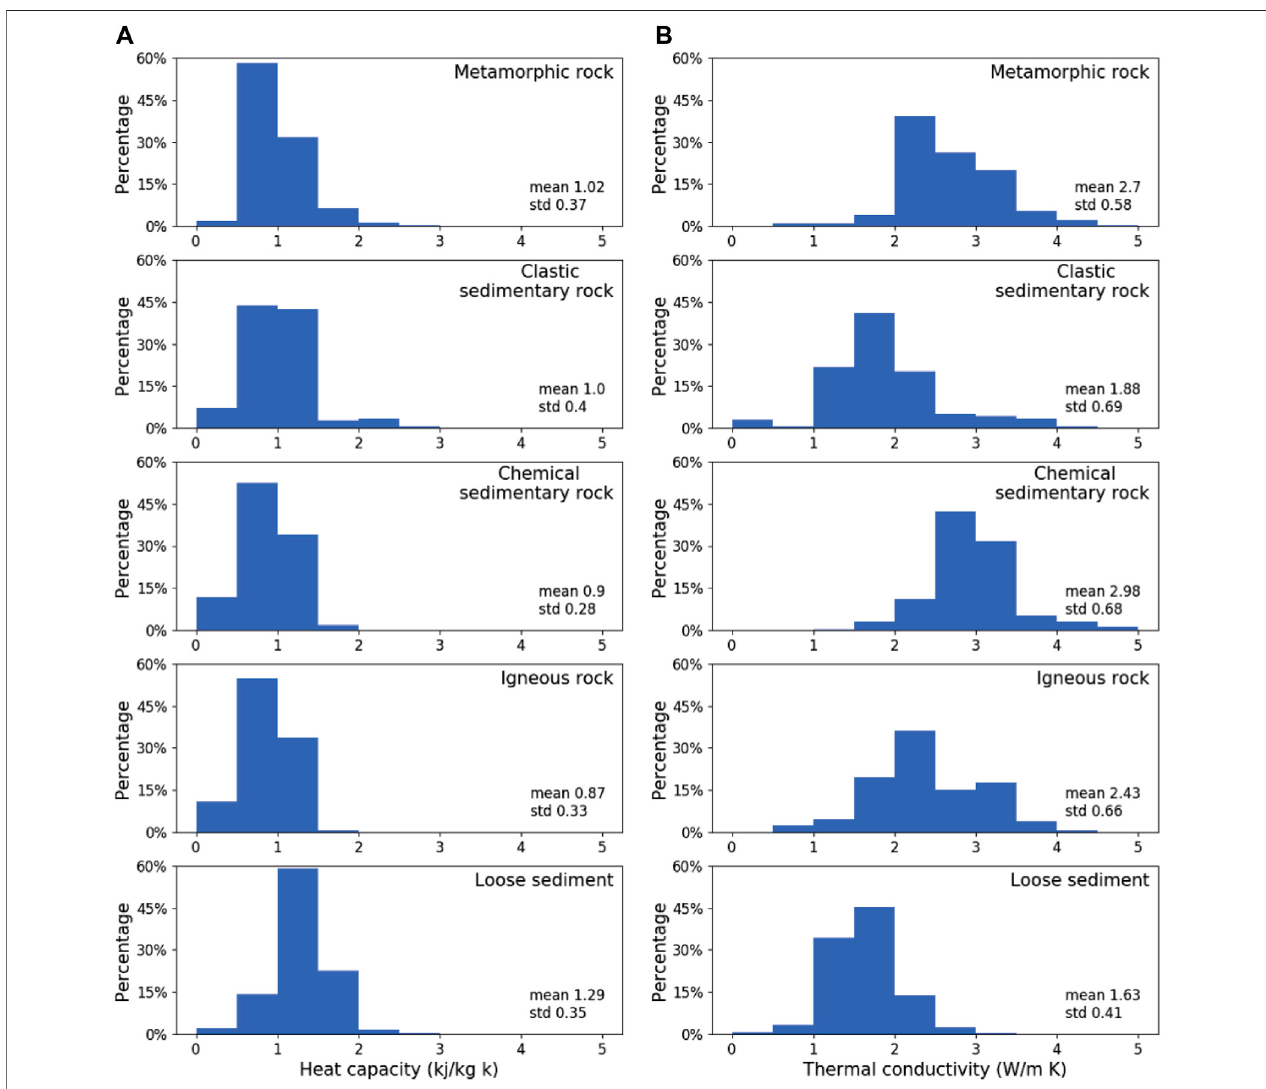
FIGURE 1 | Histograms of heat capacity (A) and thermal conductivity (B) of different rock and soil mass samples. (The y axis displays the percentage given by the samples number within the speci fi ed interval over the total number of the rock and soil samples.).